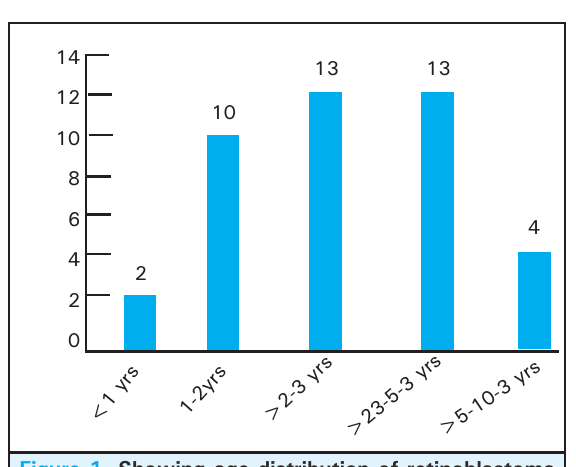
Figure 3. Showing eye involvement in retinoblastoma (n=42).